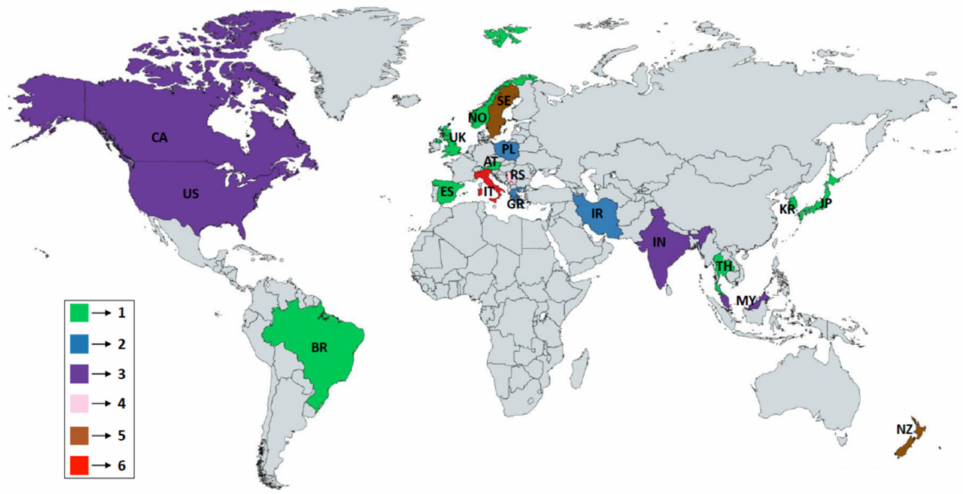
Figure 3. Geographical distribution of all contributing research